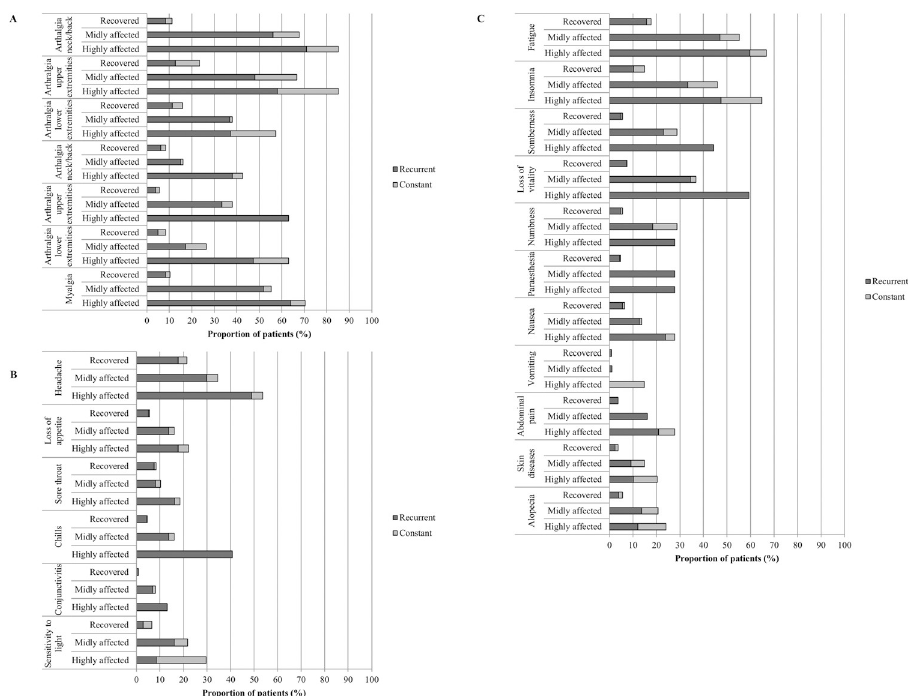
Fig 3. The nature of reported symptoms in 2017. The horizontal axis shows the proportion of reported symptoms at the time of interview in 2017, divided in their recurrent or constant nature. The rheumatic and non-rheumatic symptoms per group are shown in the vertical axis. Total recovered n = 107, mildly affected n = 87, and highly affected n = 54, classified in 2017. (A) Rheumatic symptoms since 2015; (B) Non-rheumatic symptoms measured since 2015; (C) Non-rheumatic symptoms measured only in 2017.